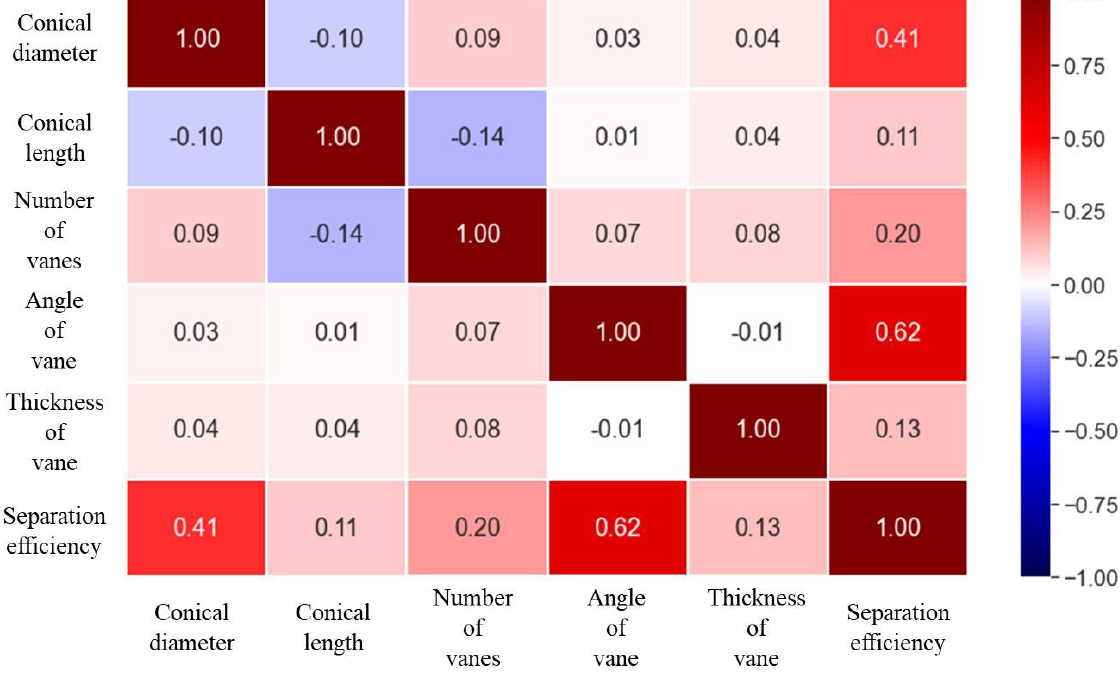
Figure 9. Results of the numerical calculation: ( a ) Separation efficiency and pressure drop for all design point, ( b ) Angle of vane and pressure drop for all design point.